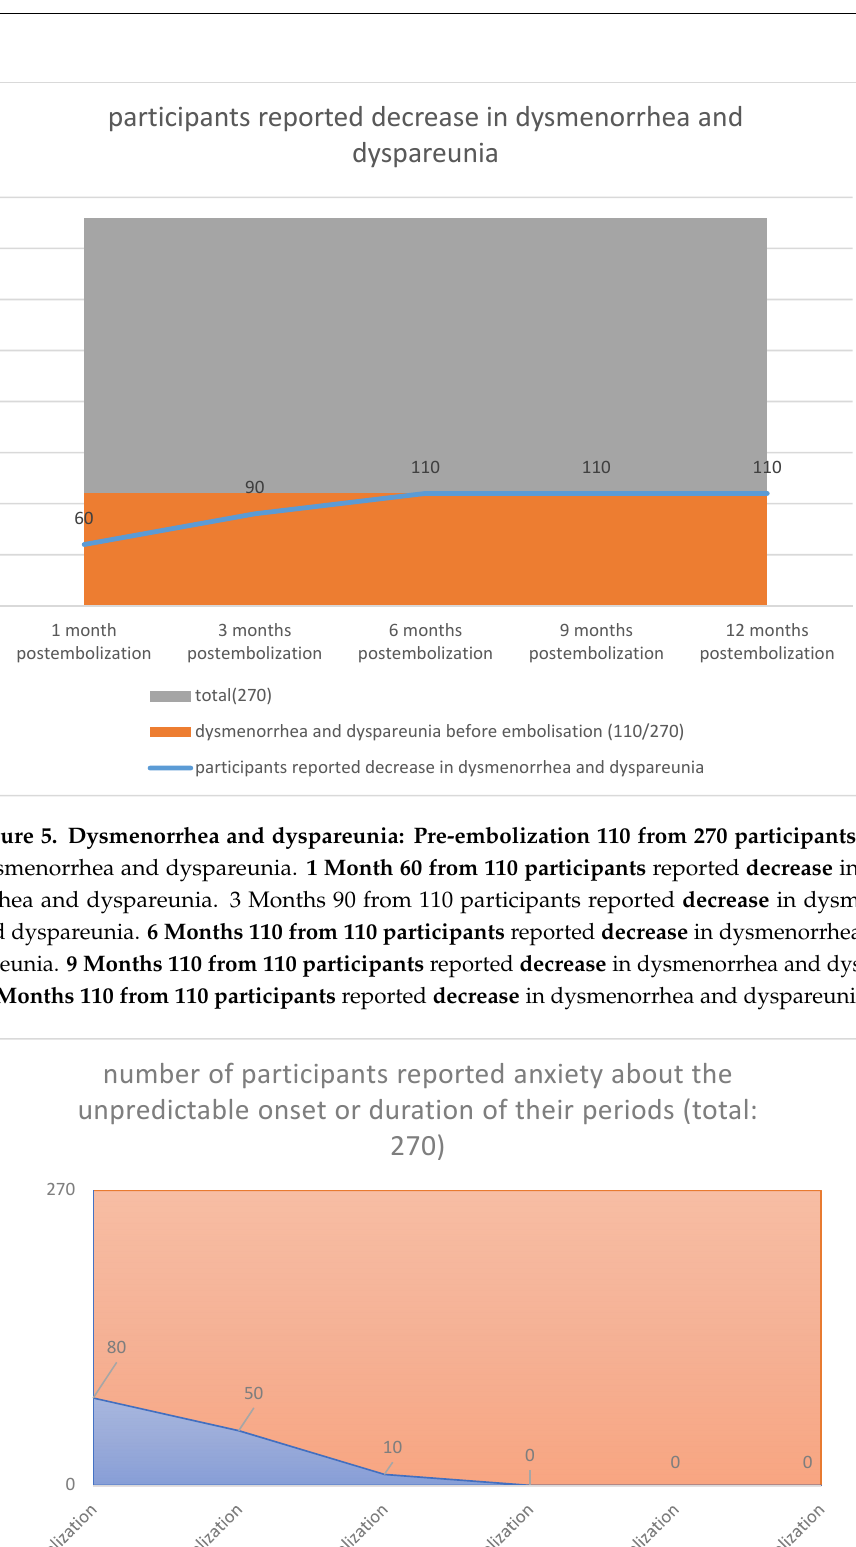
Figure 4. Presence or absence of amenorrhea: 1 Month 10 from 270 participants reported pres- ence of amenorrhea after em-bolization aged greater than 45 years. 3 Months 0 from 10 partici- pants reported presence of amenorrhea after embolization. 6 Months 0 from 10 participants re- ported presence of amenorrhea after embolization. 9 Months 0 from 10 participants reported